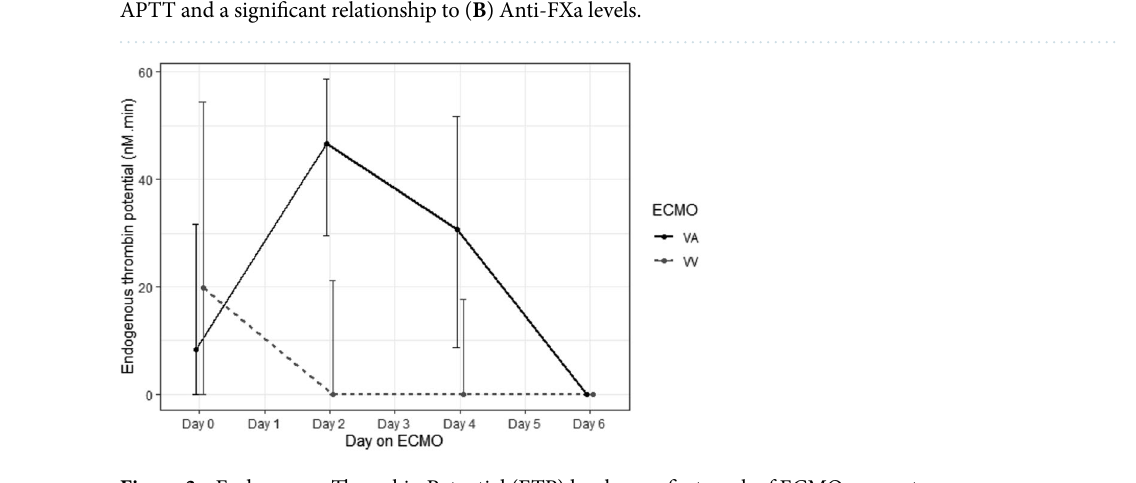
Figure 3. Endogenous Thrombin Potential (ETP) levels over first week of ECMO